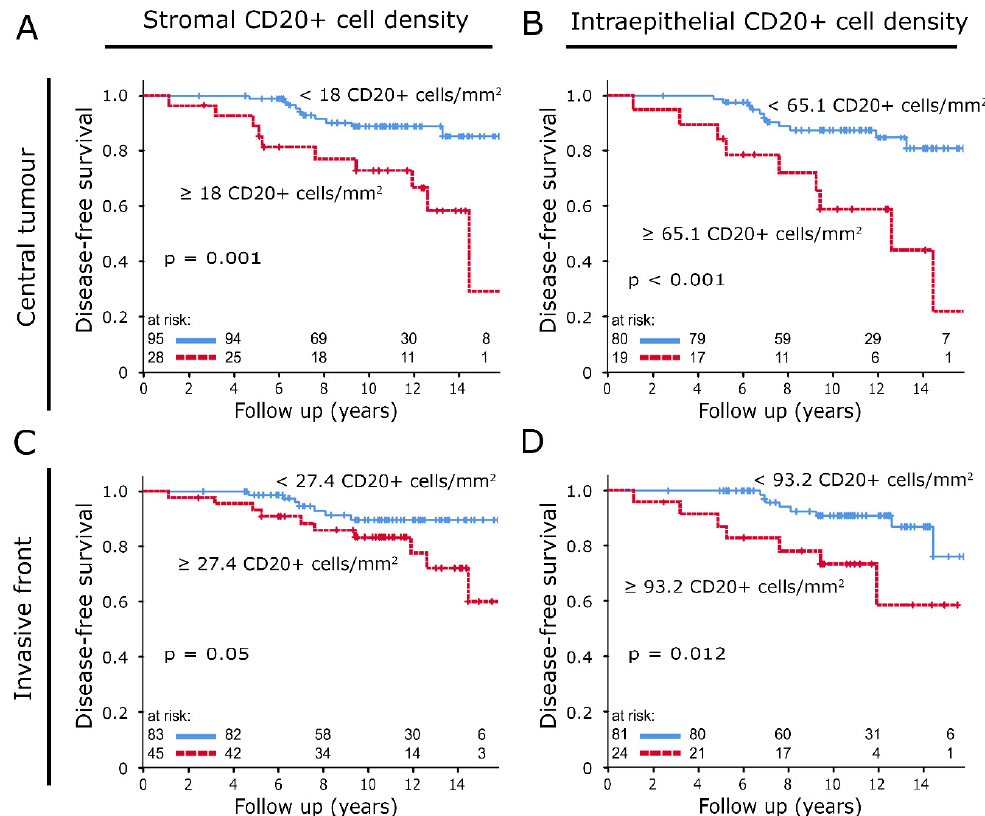
Figure 2. ( A , B ) Disease-free survival analysed with the Kaplan–Meier method and log-rank test according to CD20+ tumour-infiltrating inflammatory cell (TIIC) densities in the stromal ( A ) and intraepithelial compartment ( B ) of central tumour samples. ( C , D ) Disease-free survival analysed